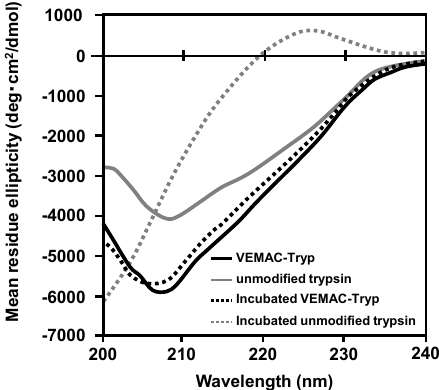
Figure 2. Circular dichroism spectra of vinylmethylether ‐ maleic acid copolymer (VEMAC) ‐ Tryp and